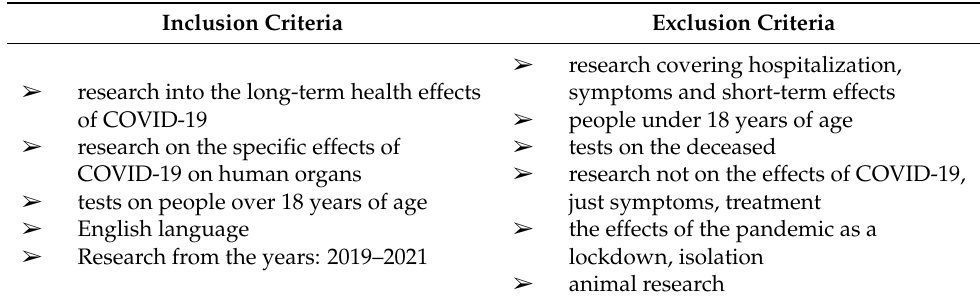
Table 1. Inclusion and exclusion